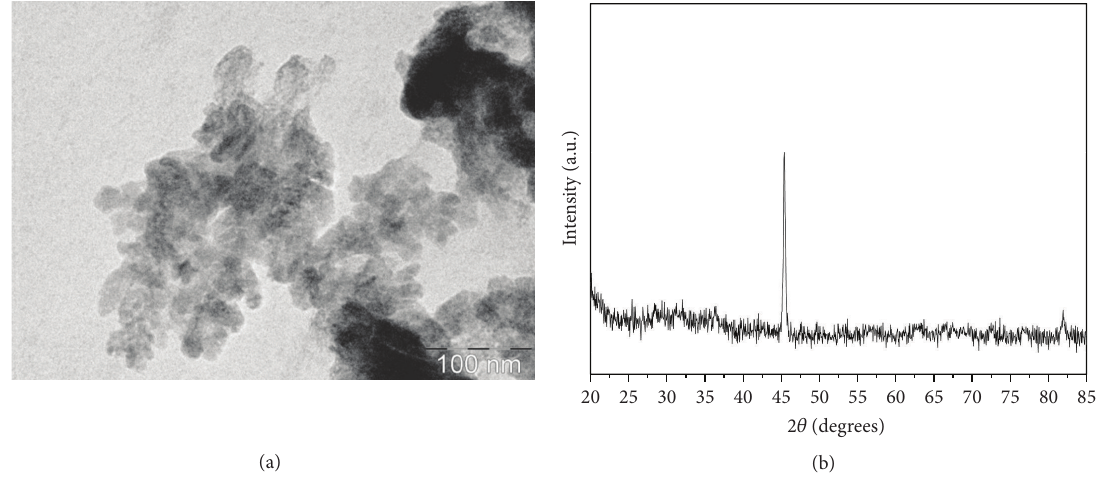
F 2: (a) Transmission electron microscope (TEM) image of laboratory-Synthesized ZVNI. (b) XRD analysis of ZVNI particles.